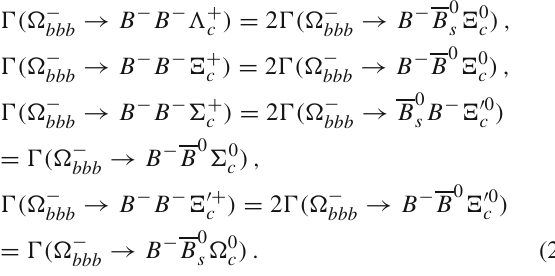
Table 4 Amplitudes for (cid:2) bbb decays into T bc and a B c meson plus a light meson